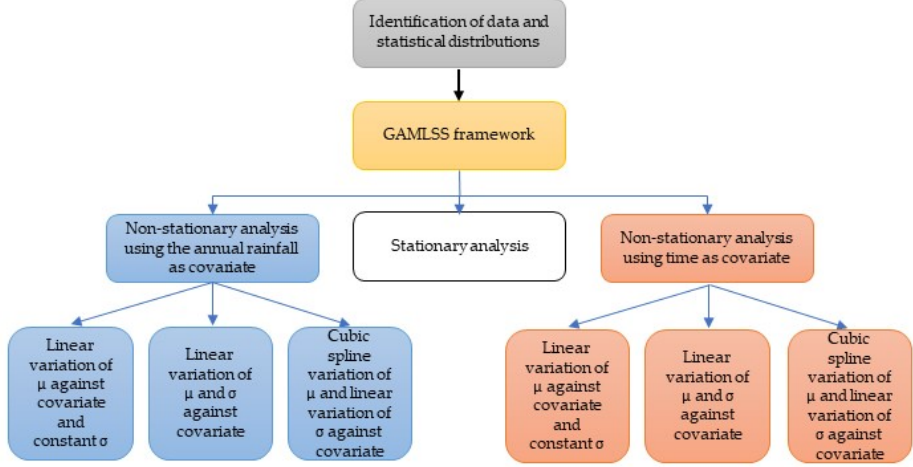
Figure 1. Flow chart of the employed methodology.